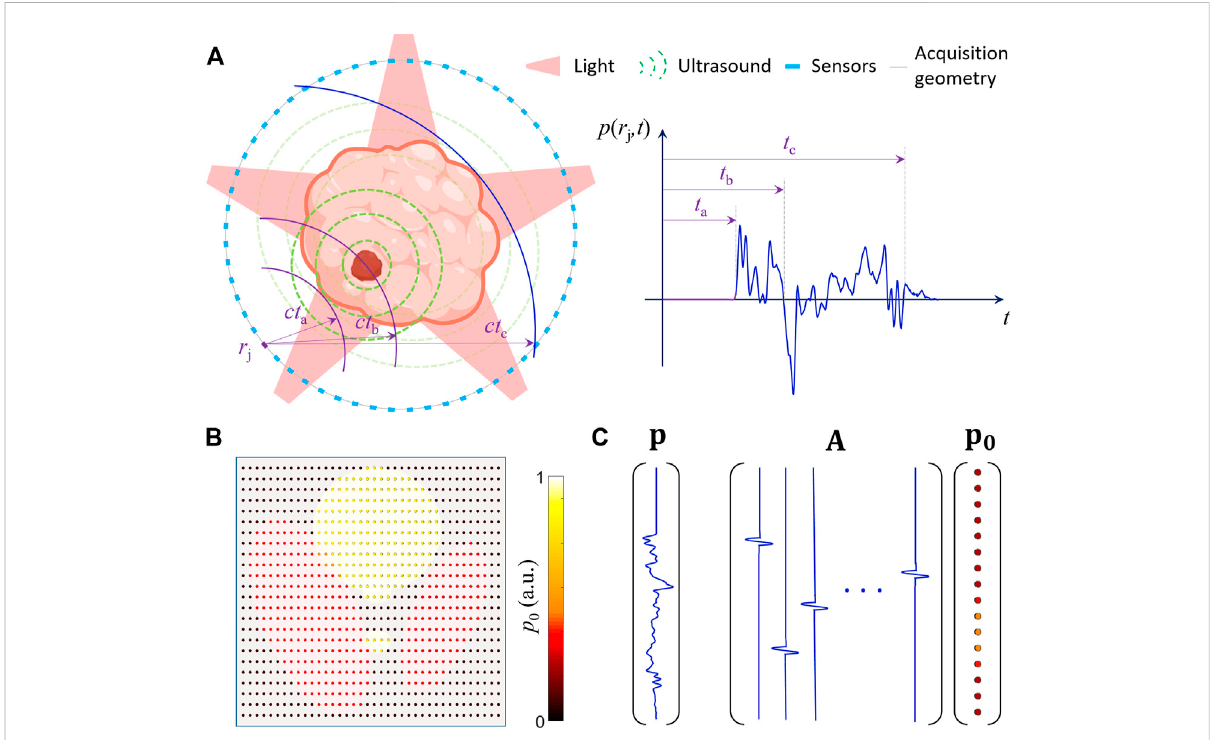
FIGURE 1 Time-domain optoacoustic (OA) forward model for short-pulsed excitation. (A) Schematic representation of the excitation of ultrasound (US) waves with light. An example of time-resolved OA signal is shown. For a uniform acoustic medium with a de fi ned speed of sound, the time-of- fl ight linearly scales with the distance to the measuring location. (B) Discretization of the OA image by considering the initial pressure at a de fi ne grid of points. (C) Discrete-to-discrete OA forward model expressedin a matrix form mapping the initial pressure expressed as acolumn vector to the measured pressure at different time points also expressed as a column vector. The columns of the model-matrix correspond to the pressure signals for a unitinitial pressure at thecorresponding pixel (or voxel). Note that onlyone collected signal is shown and the model-matrixis generallybuilt by considering multiple measuring